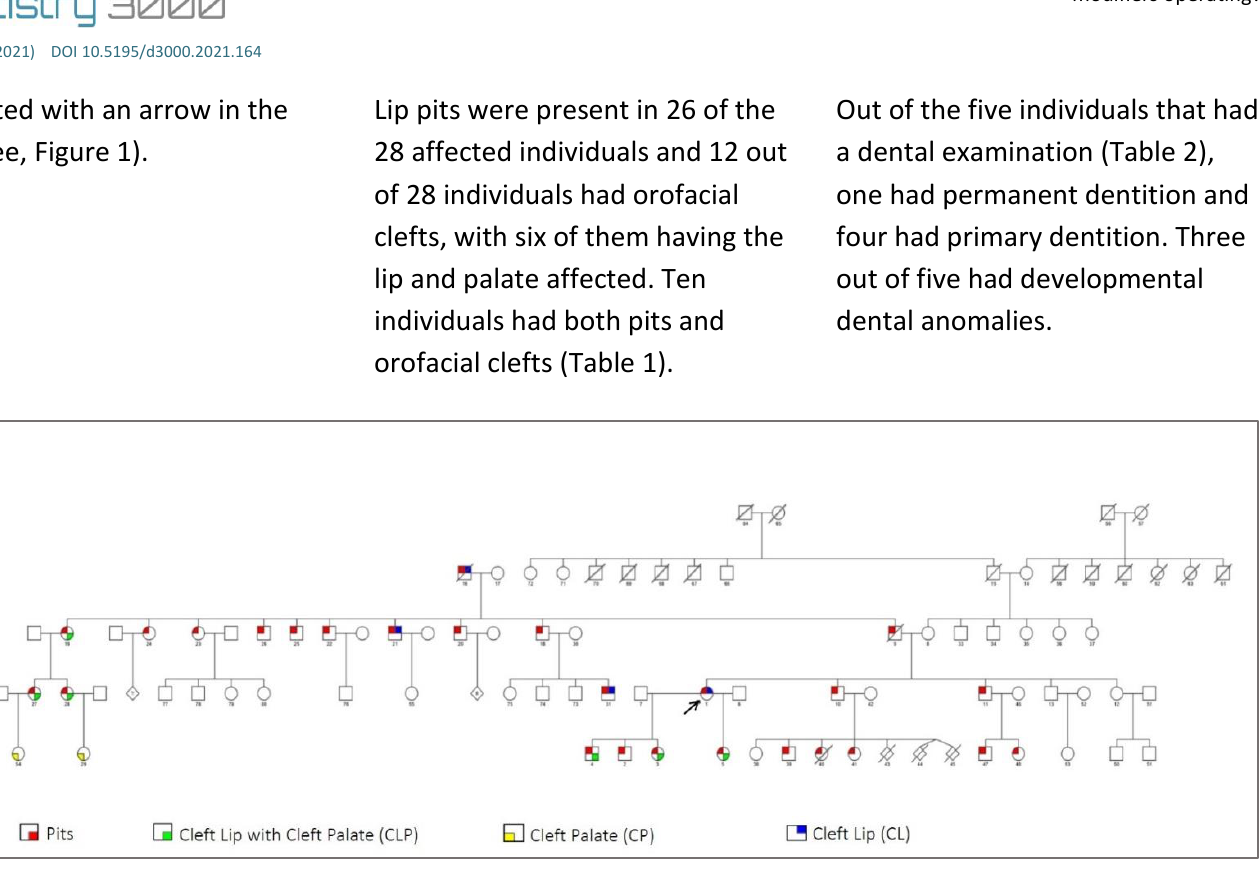
Figure 1. Pedigree showing family members affected by Van der Woude Syndrome.